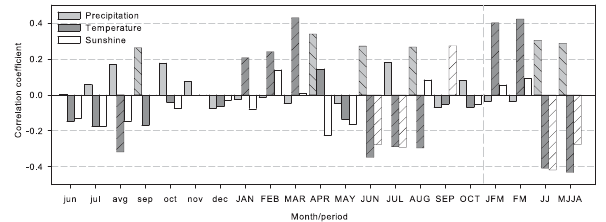
Fig. 2. Correlation coefficients (columns) between standardised chronology (average of seven site chronologies) and climate data from Bjelaˇsnica weather station; precipitation with light grey, tem- perature with dark grey and sunshine hours with white columns (Osijek weather station). Columns with pattern represent significant value (95%).